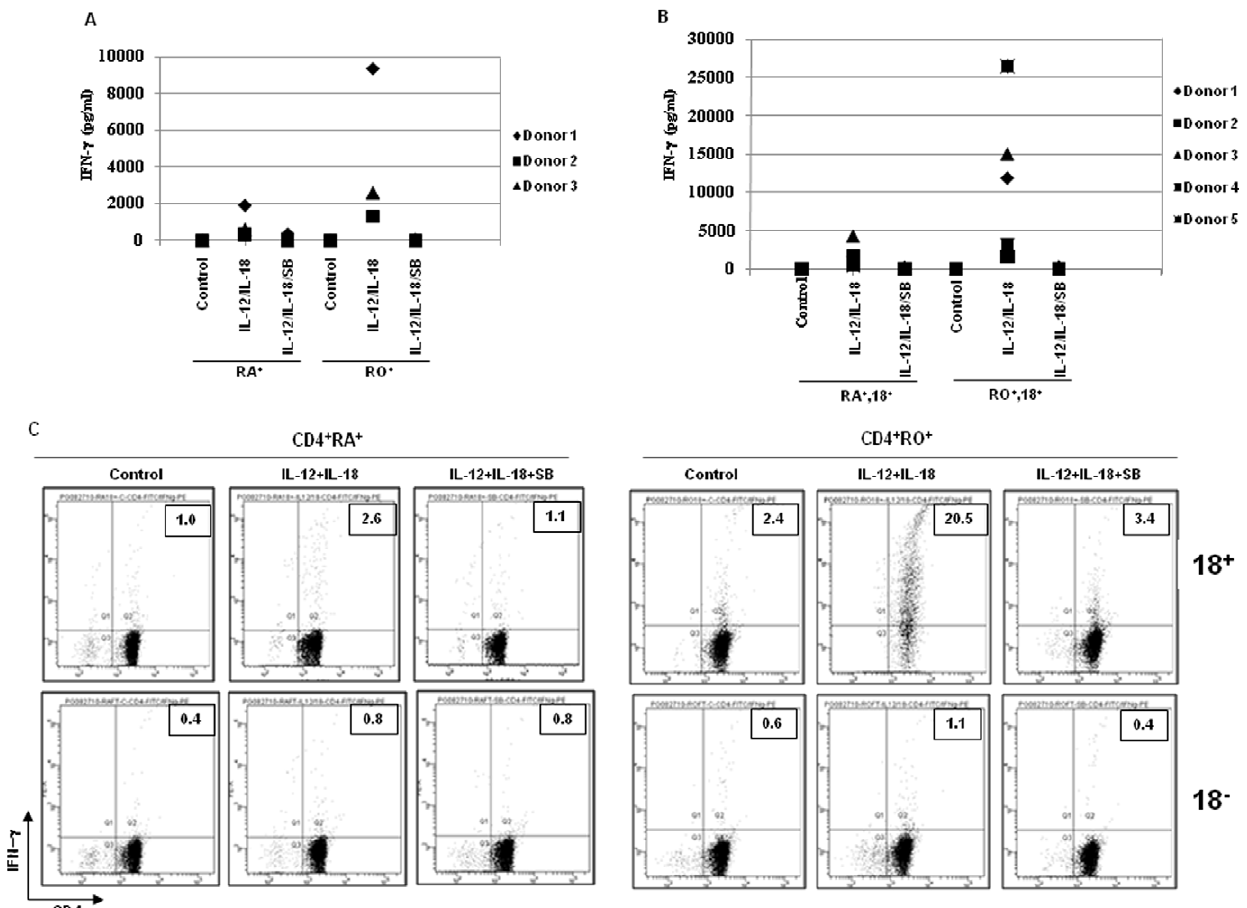
Figure 5. Production of IFN- c by the sub-population of resting human peripheral blood CD4 + T cells after activation with IL-12 plus IL-18. (A) Naı¨ve (RA + ) and memory (RO + ) cells isolated from human peripheral blood CD4 + T cells were stimulated with IL-12 and IL-18 for 48 hours in the presence or absence of SB203580. Supernatants were analyzed for IFN- c production. (B) Responsiveness of IL-18R a + T cells to IL-12 plus IL-18. Freshly isolated IL-18R a + T cells from naı¨ve (RA + 18 + ) and memory (RO + 18 + ) CD4 + T cells were treated with IL-12 plus IL-18 for 48 hours in the presence or absence of SB203580. Supernatants were analyzed for IFN- c production. (C) IL-18R a + (upper panel, 18 + ) and IL-18R a 2 (lower panel, 18 2 ) T cells from naı¨ve (CD4 + RA + ) and memory (CD4 + RO + ) T cells were treated with IL-12 plus IL-18 for 48 hours in the presence or absence of SB203580, and the cells were then used for intracellular staining for IFN- c . One representative donor among three is shown here, and data from rest of the donors are shown in Tables 2 & 3.